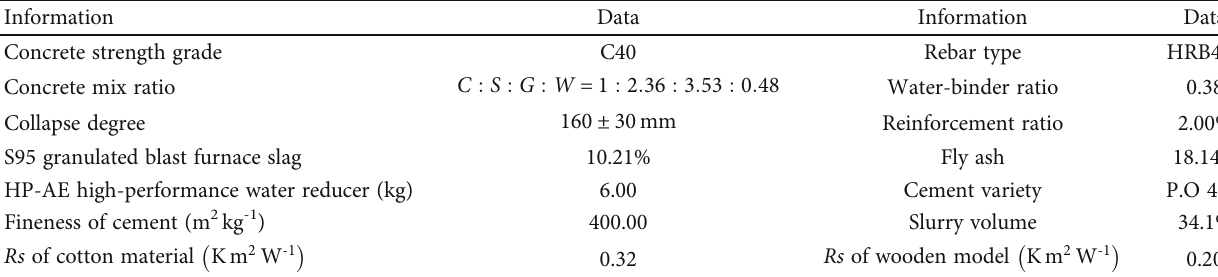
Table 2: Basic information of mass concrete.